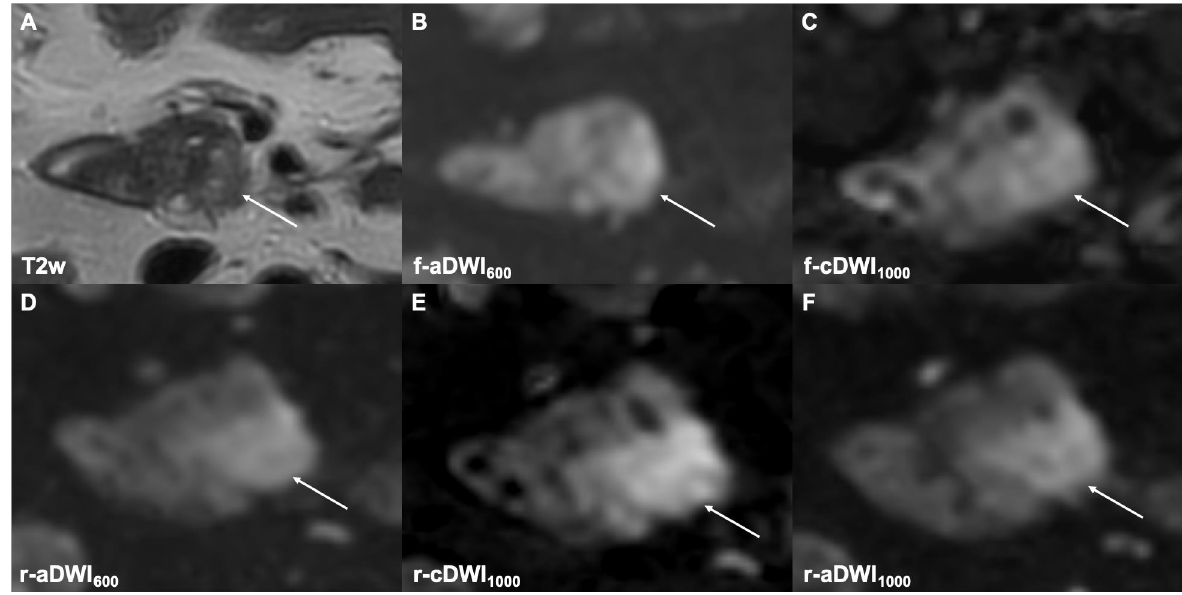
Figure 2. The axial T2w image shows a small tumor in the pancreatic head ( A , white arrow) with an unclear border (type 2) to the adjacent parenchyma in both the f-aDWI600 ( B ) and f-cDWI1000 ( C ) images. Better lesion detection and tumor-to-parenchyma contrast (type 1) are depicted in the r-cDWI1000 ( E ) image compared to the r-aDWI600 ( D ) image and the directly acquired image at b = 1000 s/mm 2 ( F ). The labeling in image ( E ) has been corrected.